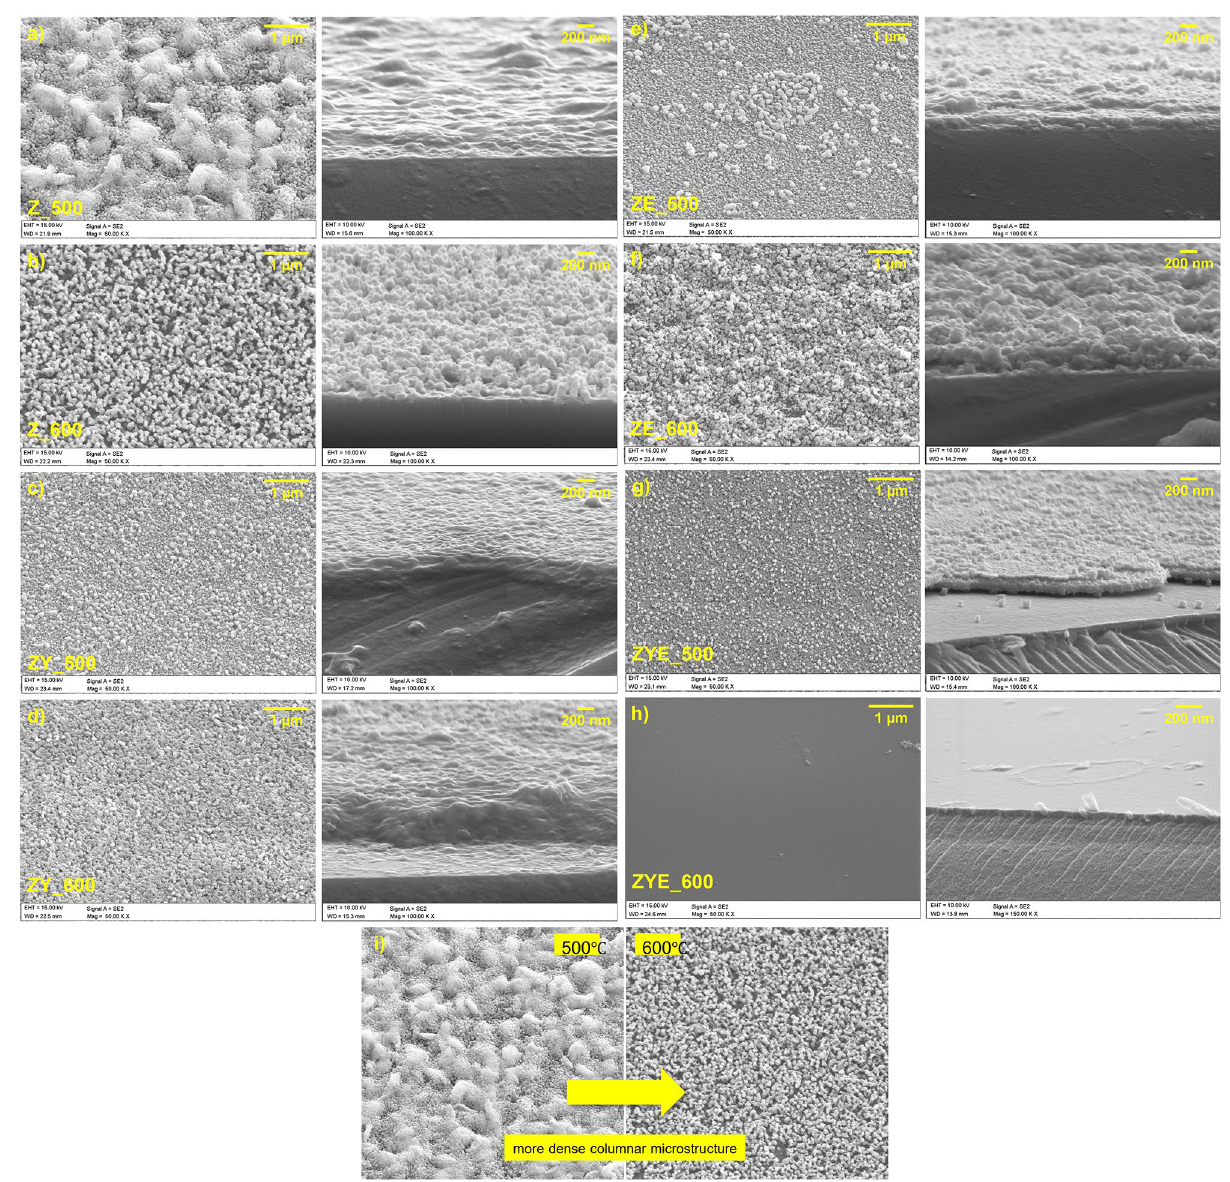
Figure 2. SEM images of hybrid thin films: topography and cross-section ( a – h ) and comparison of columnar structure of thin films calcined in two different